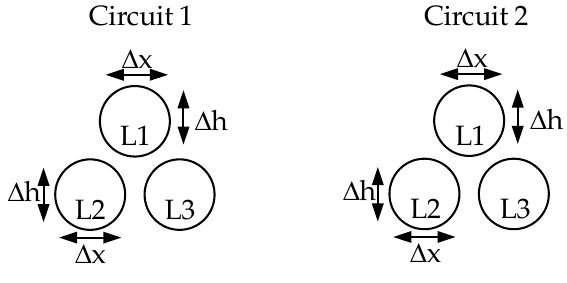
Figure 25. The idea of cable spacing search.